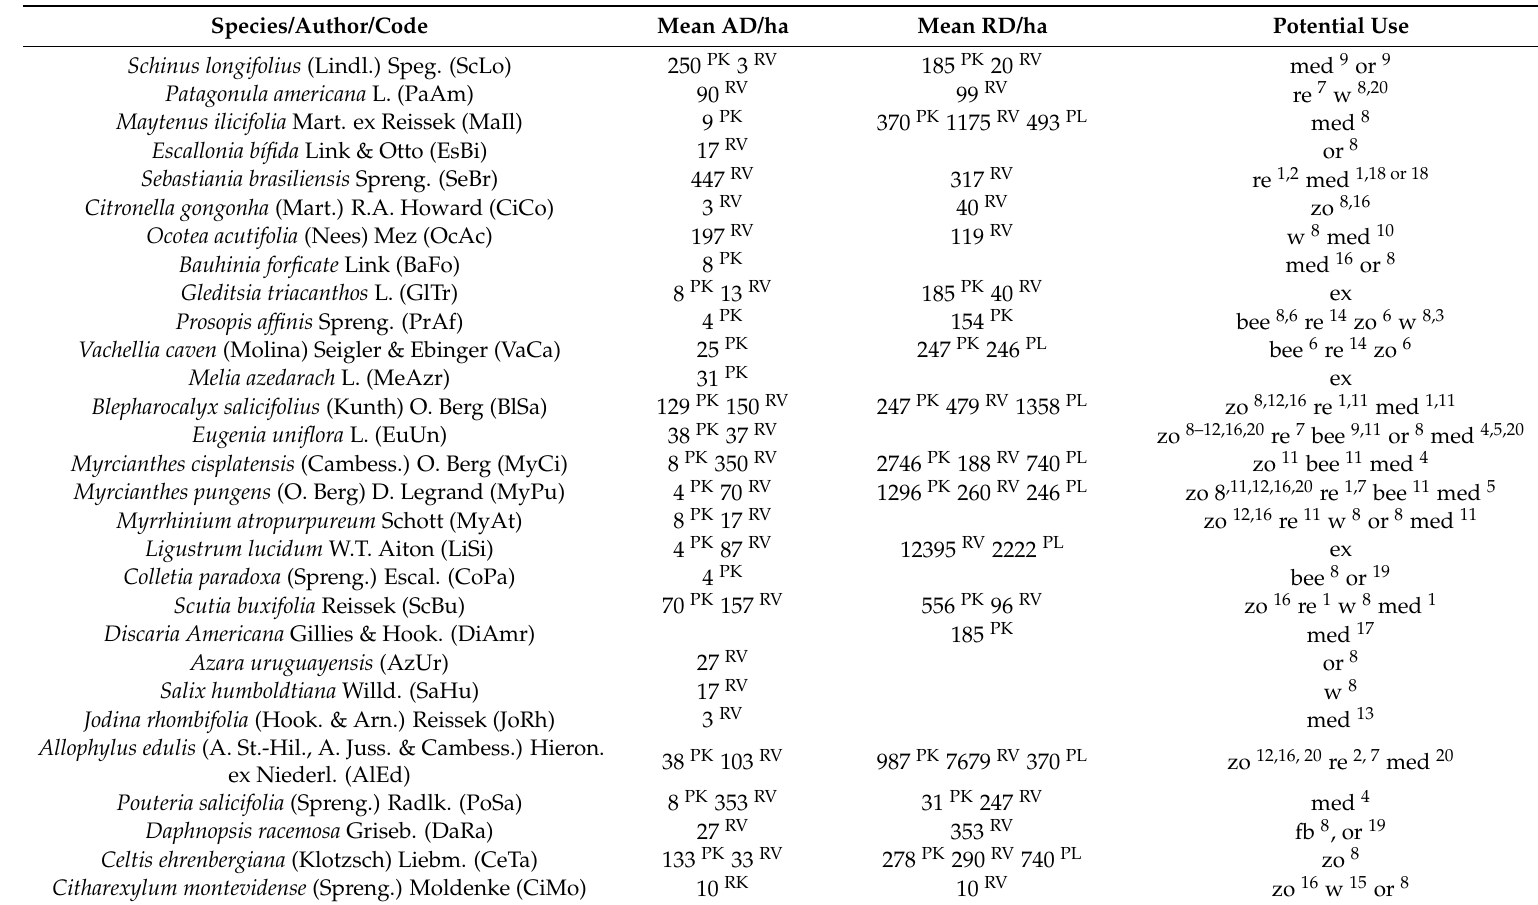
Table 1. Species composition and potential use of woody species in different Uruguayan forest types: park forests (PK), riverine forests (RV), and Eucalyptus plantations (PL). Tree density (AD), regeneration density (RD), and potential use for each species are given. Use categories are local fiber (fb), source of nectar for bees and honey production (bee), medicine (med), ornamental use (or), soil restoration (re), wood (w), and animal foods (zoo). Exotic species (ex) have been introduced originally in the region for ornamental purposes [36]. References are indicated by superscript numbers. For use references, see Appendix